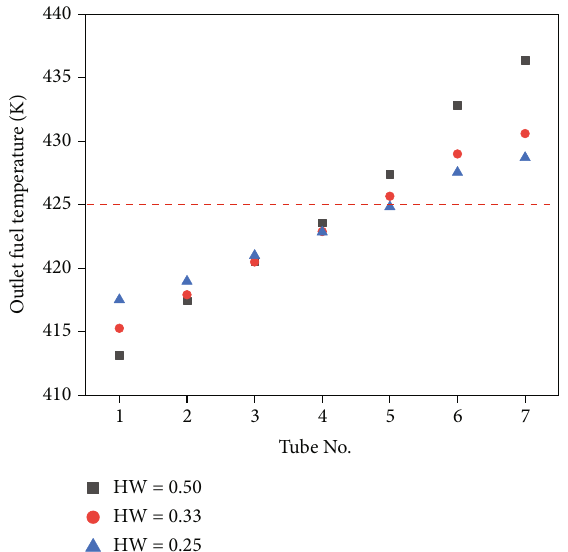
Figure 12: Outlet fuel temperature with di ff erent HW values.